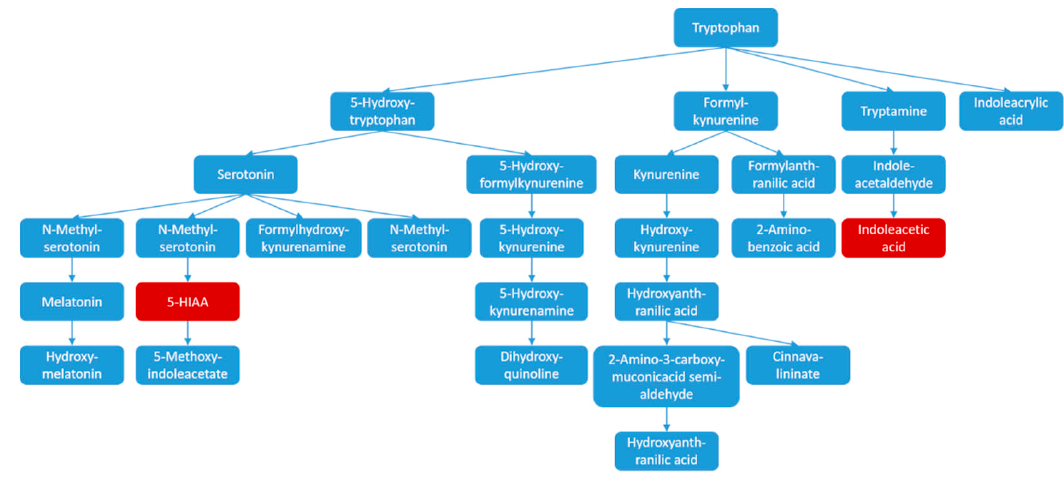
Figure 6. Tryptophan metabolism pathway.